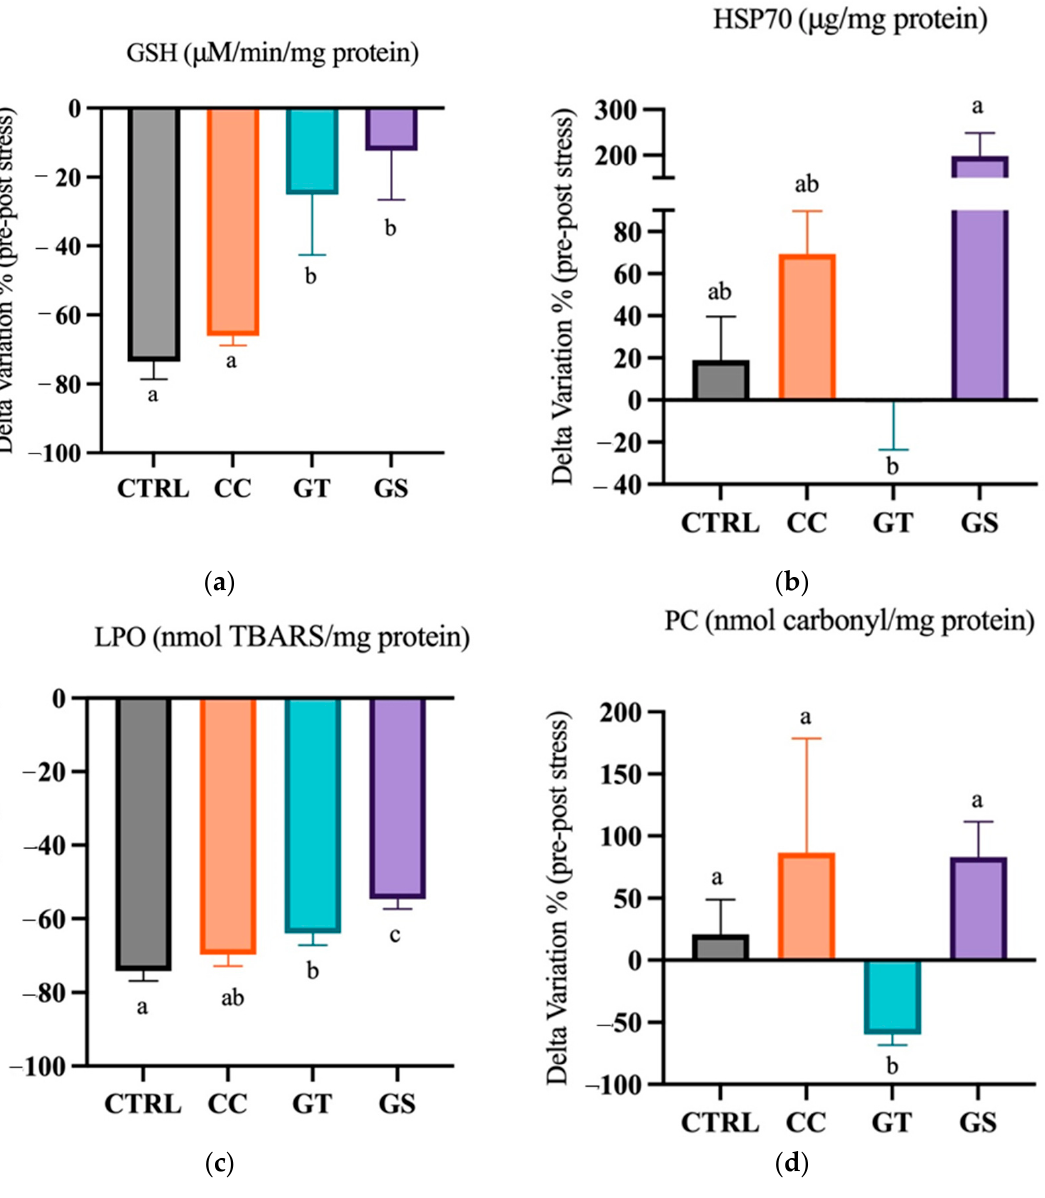
Figure 4. Delta variation (%) of the response of oxidative and cellular stress-related biomarkers ( a ) glutathione-s-transferase (GSH), ( b ) heat shock protein 70 (HSP70), ( c ) lipid peroxidation (LPO), and ( d ) protein carbonyl (PC) from standard to chronic stress conditions of Senegalese sole fed with different diets (CTRL, CC, GT, and GS). Values are presented as means ± SD, n = 3. Different superscript letters indicate significant differences ( p < 0.05, 1-way ANOVA) between the dietary treatments.